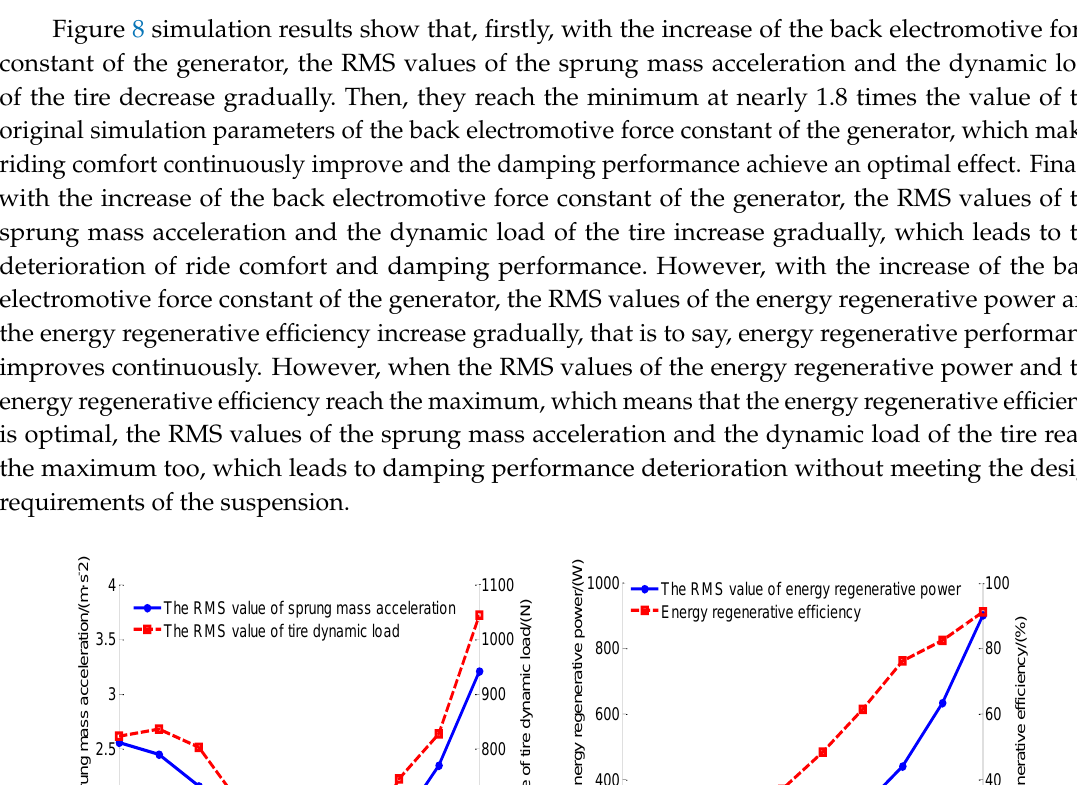
Figure 6. Influence of the effective area of the hydraulic cylinder piston on evaluation indicators: ( a ) Influence of the effective area of the hydraulic cylinder piston on the damping performance; ( b ) Influence of the effective area of the hydraulic cylinder piston on energy regenerative performance.